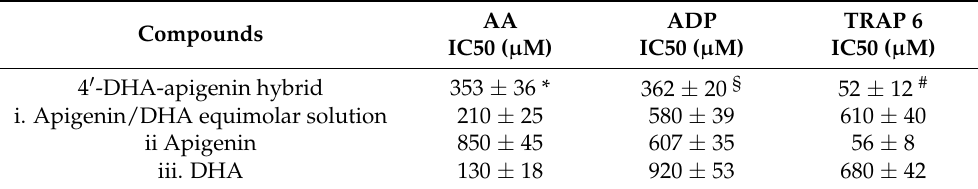
Table 1. IC50 values of the inhibitory effect of 4 ′ -DHA-apigenin hybrid, apigenin/DHA (equimolar solution), apigenin and DHA on AA, ADP and TRAP-6-induced platelet aggregation. AA ADP TRAP 6 Compounds IC50 ( μ M ) 4 ′ -DHA-apigenin hybrid 353 ± 36 *